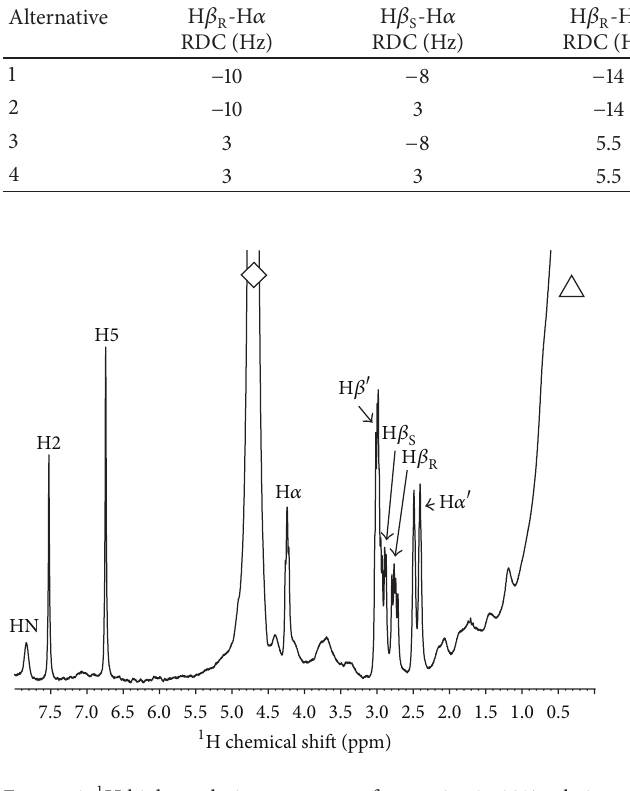
Figure 3: 1 H high resolution spectrum of carnosine in 20% gelatin sample (500 MHz). Letter-labeled peaks belong to carnosine and strong background peaks are from the silicon tube (labeled by triangle) and water (rhomb). The broad low intensity peaks are assigned to the